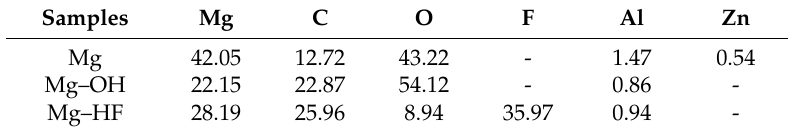
Figure 2. The survey X-ray photoelectron spectroscopy (XPS) spectra for different samples. Table 1. X-ray photoelectron spectroscopy (XPS) surface atom percentage of different samples (wt